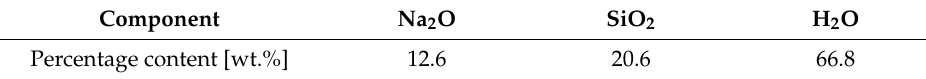
Table 4. Composition of liquid alkaline solutionGeosil 34417 and water.